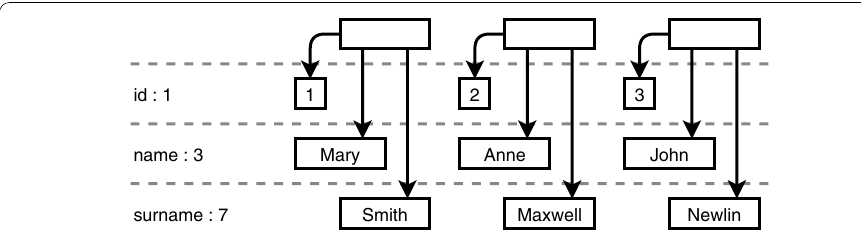
Fig. 9 Forest containing three records corresponding to a row of a relational table